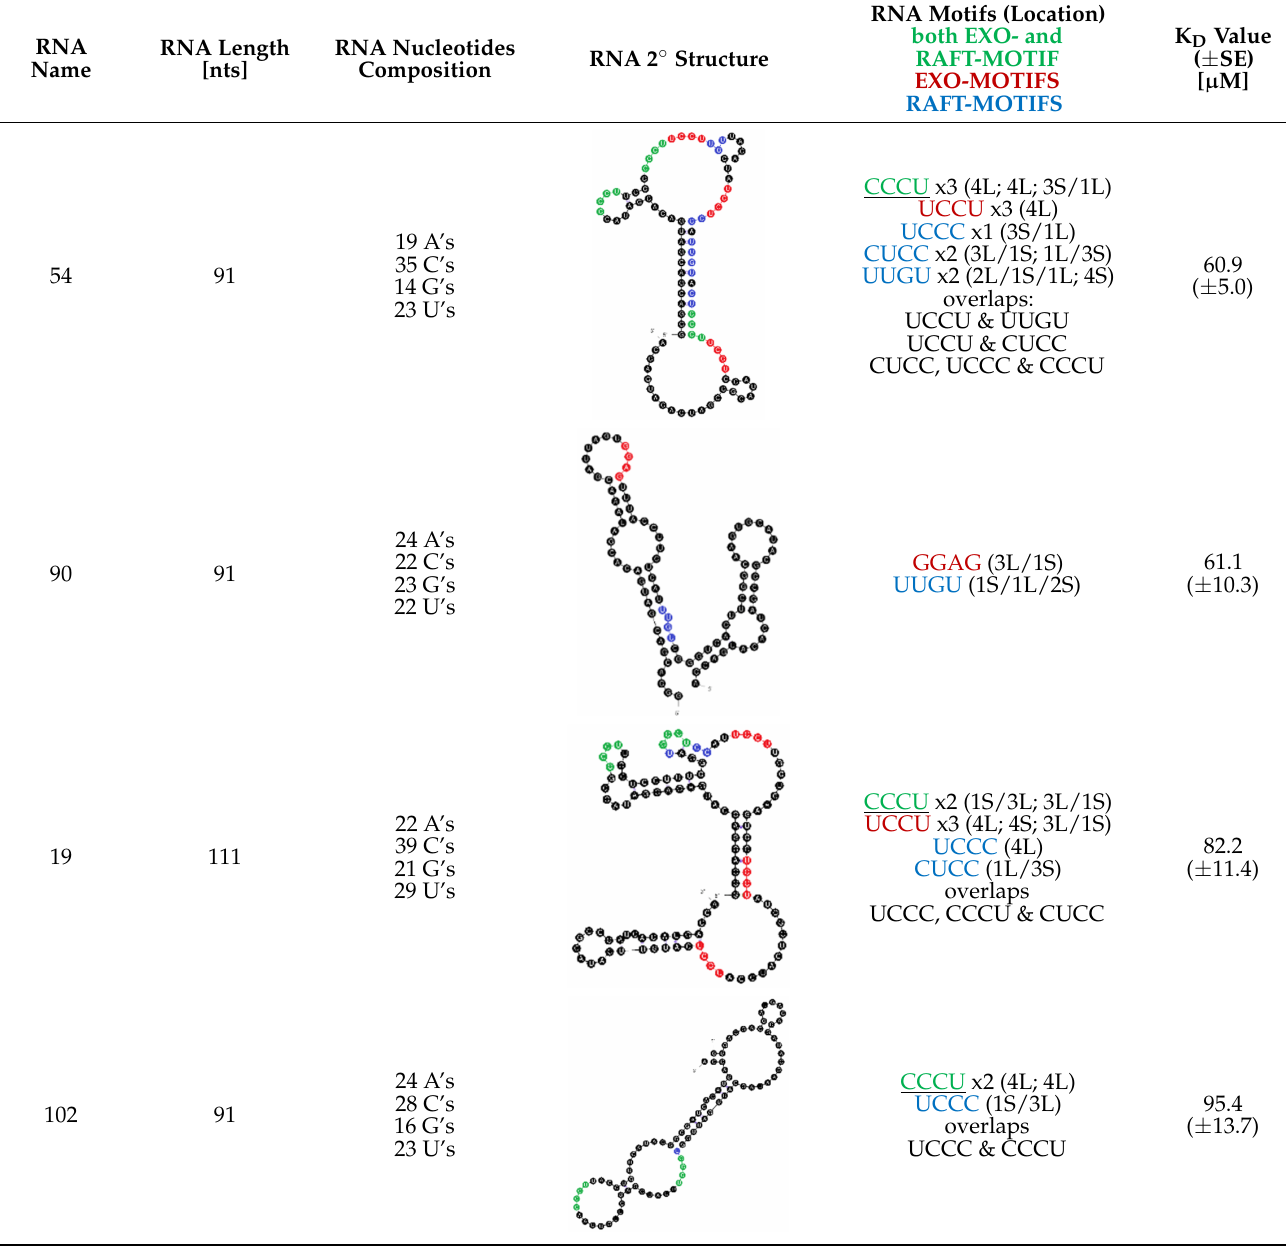
Table 2. Analyzed RNA aptamers with marked location of RNA motifs within the secondary structure. Both EXO- and RAFT-motif CCCU is marked in green, other EXO-motifs (GGAG, UGAG, and UCCU) are marked in red and other RAFT- motifs (UCCC, CUCC, UUGU) are marked in blue. Abbreviations used to name the location of RNA motifs in the secondary structure of the RNA molecule: the number (from 1 to 4) refers to the number of nucleotides located in a particular position of the 4-nucleotide motif; L or S refers to the loop or stem location, respectively (e.g., 4L—means that all 4 nucleotides are located in the loop, 3S/1L—3 first nucleotides of the RNA motif are located in the stem, and the last one is located in the loop). The overlapping motifs are noted. The K D values of aptamer-membrane raft interactions are the mean values ( ± SE) of three independent experiments. The RNA sequences were folded using the m-fold program [47] at 37 ◦ C. The 2 ◦ structures presented have the lowest free energy among the structural variants predicted by m-fold. Locations of RNA motifs in the alternative structures are presented in the Supplementary Table